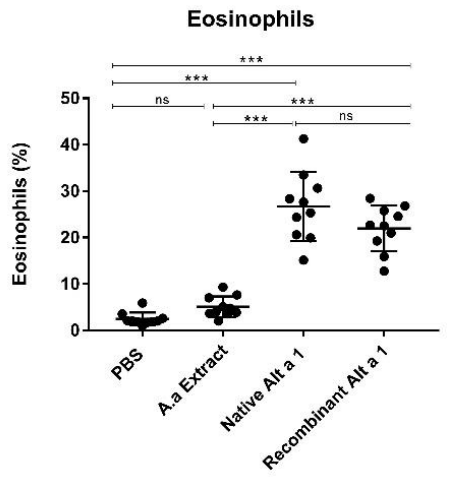
Figure 6. Quantification of eosinophil in BAL. Eosinophils are plotted as the percentage of the mean of the different groups (PBS, A. alternata Extract, nAlta 1 and rAlta 1). Data shown as mean ± SEM. ***, p < 0.001; ns: no statistically significant differences ( p > 0.05).